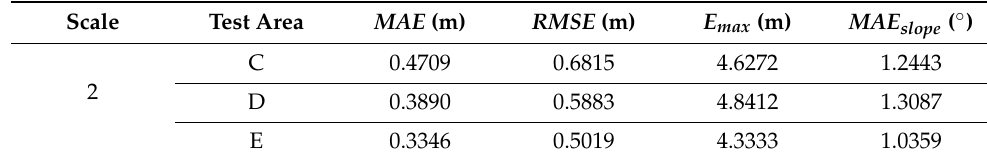
Figure 11. Results after reconstruction for a large-scale test area with a resolution of 5 m as an example. Table 2. Performance evaluation of our method at the reconstruction scale of 2 on the DEM datasets for the Maryland test area.